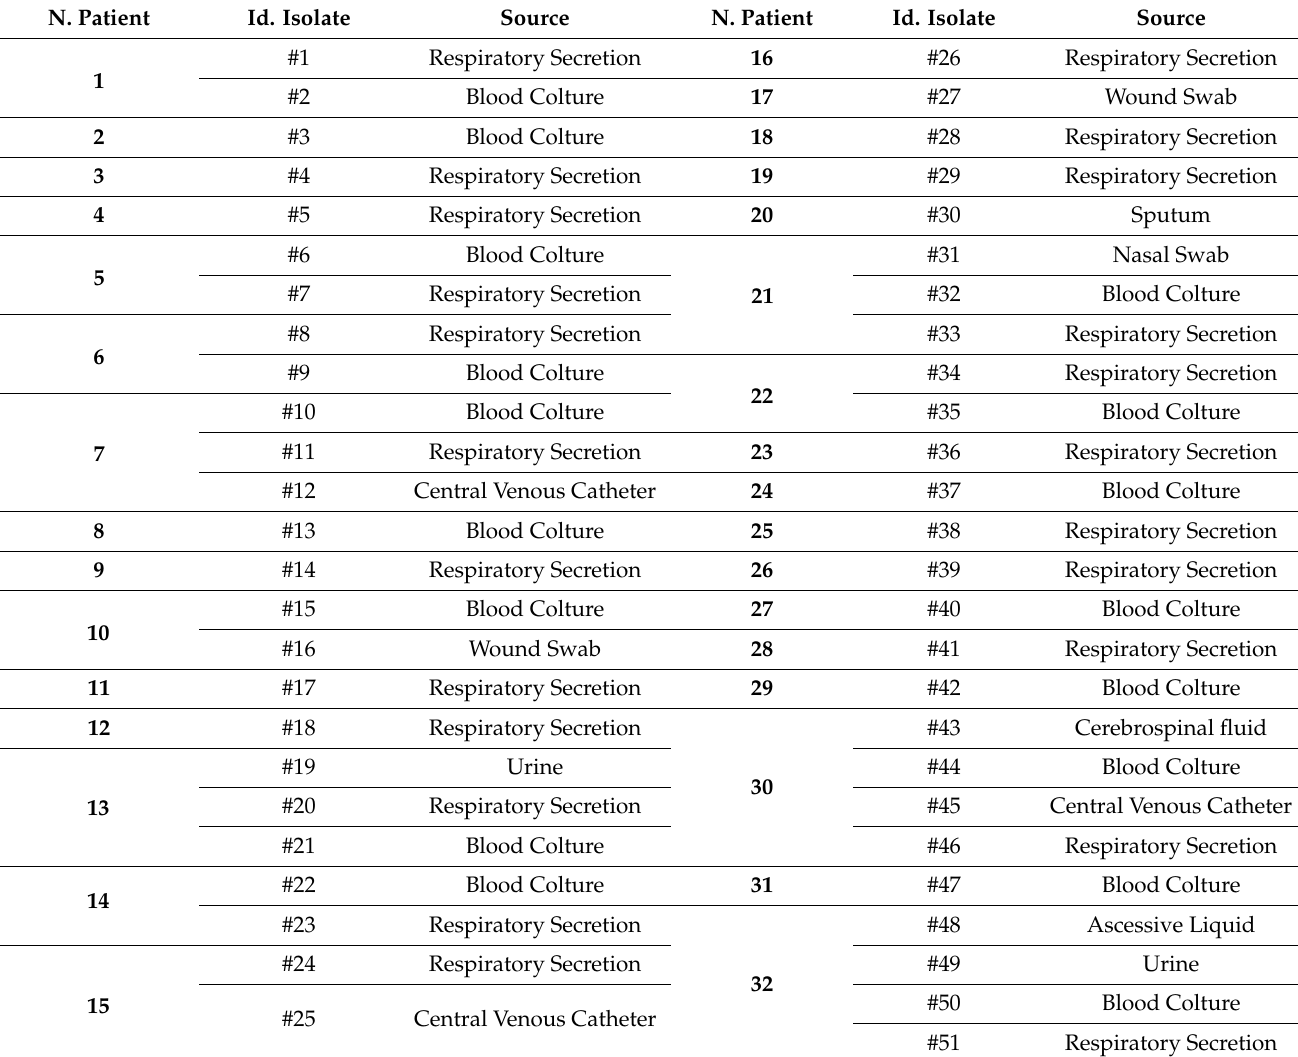
Table 1. Source of the isolates in the patient